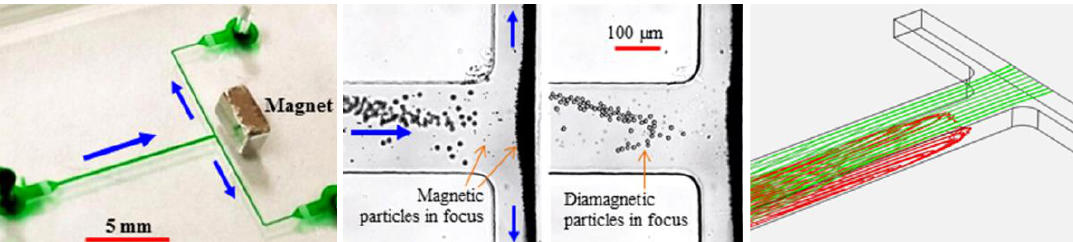
Figure 9. Diamagnetic particle enrichment in the flow of magnetic fluids through a T-shaped microchannel with a single permanent magnet: picture of the microfluidic chip (left), top-view snapshot images for the simultaneous trapping of 9.9 µm diamagnetic and 2.85 µm magnetic beads at the T-junction (middle), and isometric view of the numerically predicted 3D trajectories of diamagnetic (red) and magnetic (green) beads (right). Adapted with permission from Zhou et al. [109], © 2015 American Institute of Physics.